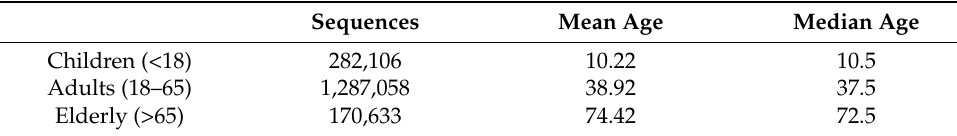
Table 1. Details of SARS-CoV-2 data used in this study. Data retrieved from GISAID and each of the three data subsets were separately analyzed using